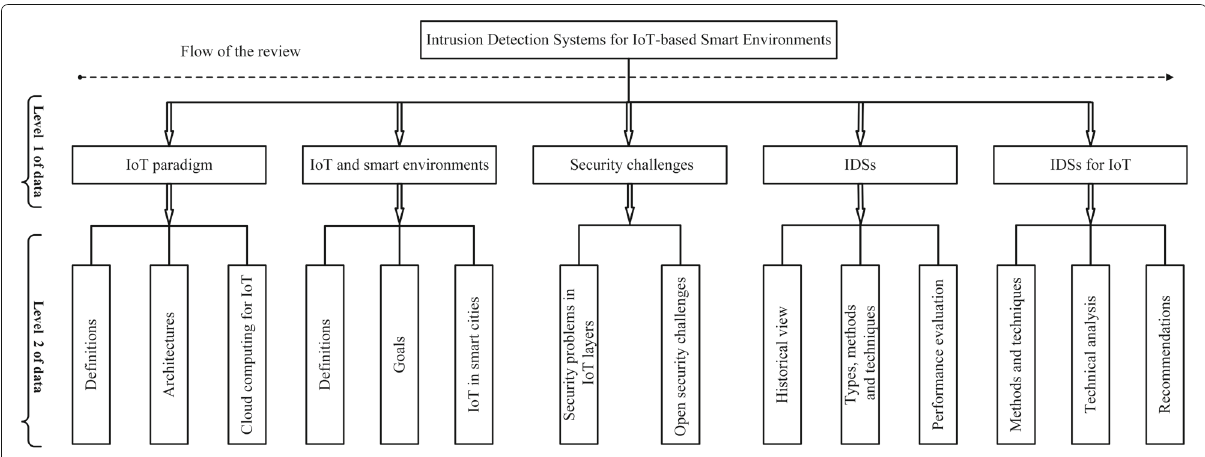
Fig. 1 The flow of this article, separated into two levels; level 1 describes the main topics, and level 2 describes the detailed points